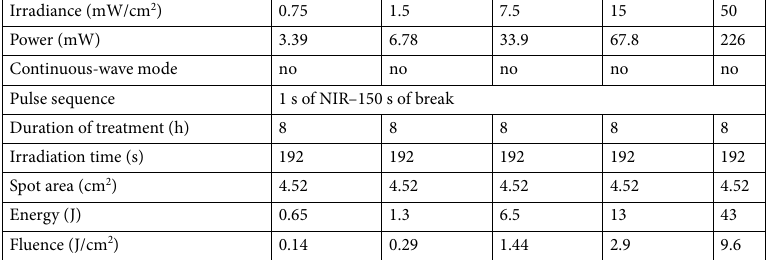
ence in the slope of the hemolysis curve indicates a narrower distribution of the population in terms of osmotic properties (p < 0.01) (Fig. 7).